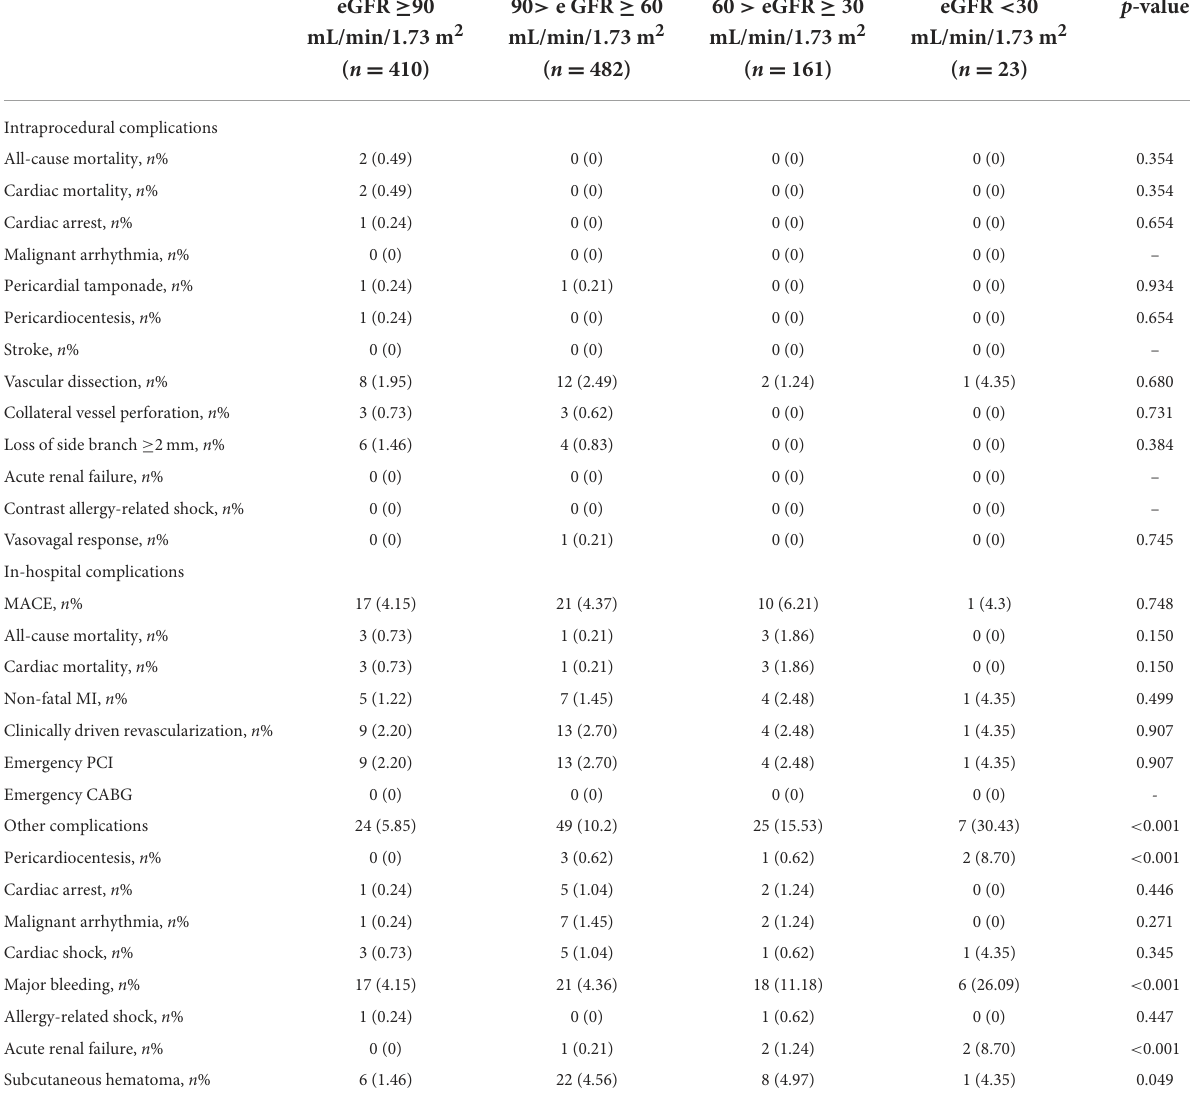
TABLE 3 Intraprocedural and in-hospital